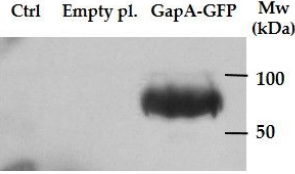
Figure 5. Validation of DDX3X interaction with GapA. HEK293T lysates transfected with empty plasmid pEGFP-C2 (empty pl.), pEGFP-C2:: gapA (GapA-GFP), or non-transfected (Ctrl) were subjected to immunoprecipitation and eluates were analyzed by Western blot probing for DDX3X.